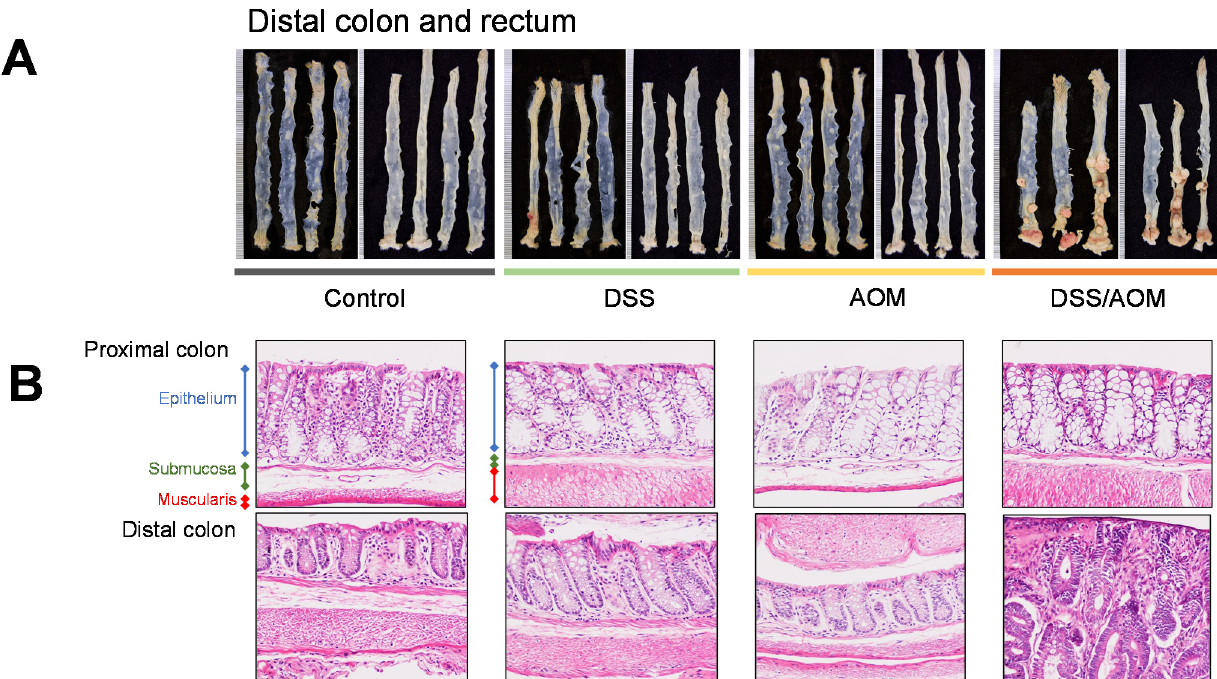
Figure 1. Induction of inflammation induced colon cancer in mice. Female BALB/c were randomized as untreated controls or mice treated with three daily doses of AOM and/or three subsequent cycles of 2% DSS-supplemented for four weeks. ( A ) Gross visualization of colon tumor development six months after the indicated treatment. ( B ) Representative hematoxylin and eosin -stained sections showing histopathological changes in colonic mucosa after the indicated treatments. DSS, dextran sodium sulfate; AOM, azoxymethane; DSS/AOM; dextran sodium sulfate + azoxymethane. High power magnification = 200×, low power magnification = 100×.